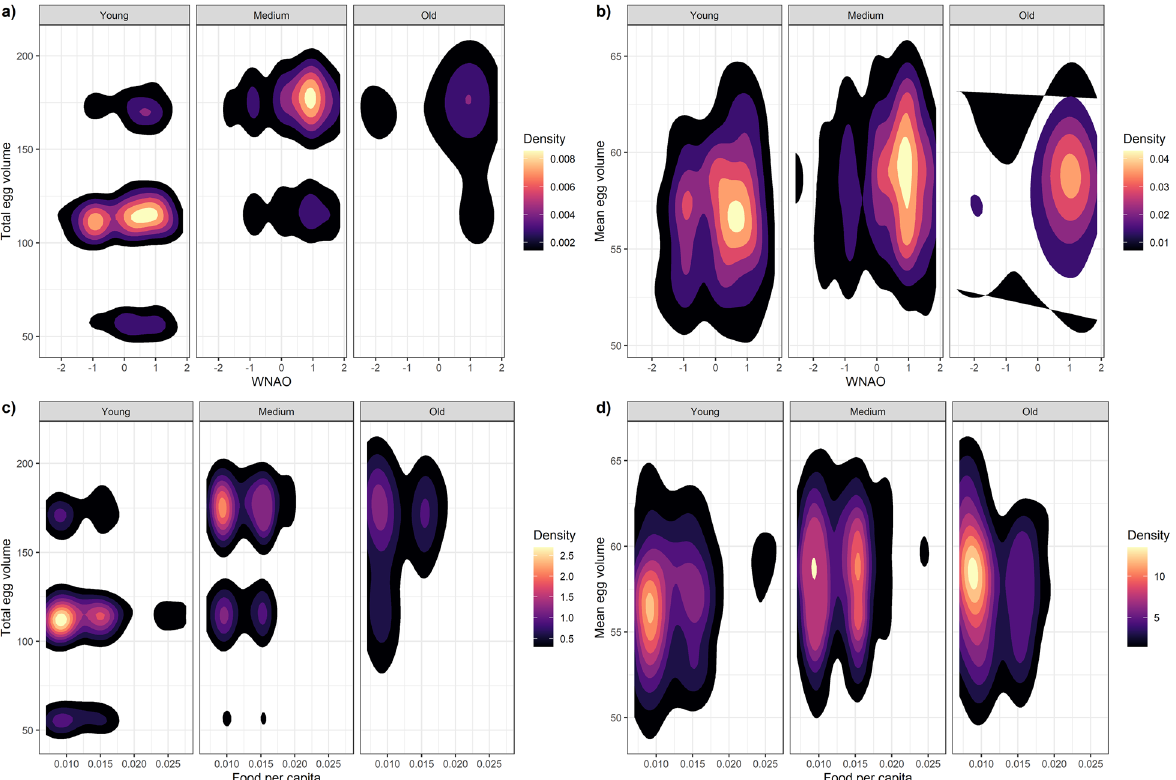
Figure 1. Density plots of the raw data depicting the effects of ( a ) age and winter climatic conditions (Winter NAO) on total egg volume, ( b ) age and winter climatic conditions (Winter NAO) on mean egg volume ( c ) age and food availability per capita on total egg volume and ( d ) age and food availability per capita on mean egg volume. Egg volume in cm 3 . Young: 3–4 years old, middle-aged: 5–19 years old, and old individuals: > 20 years